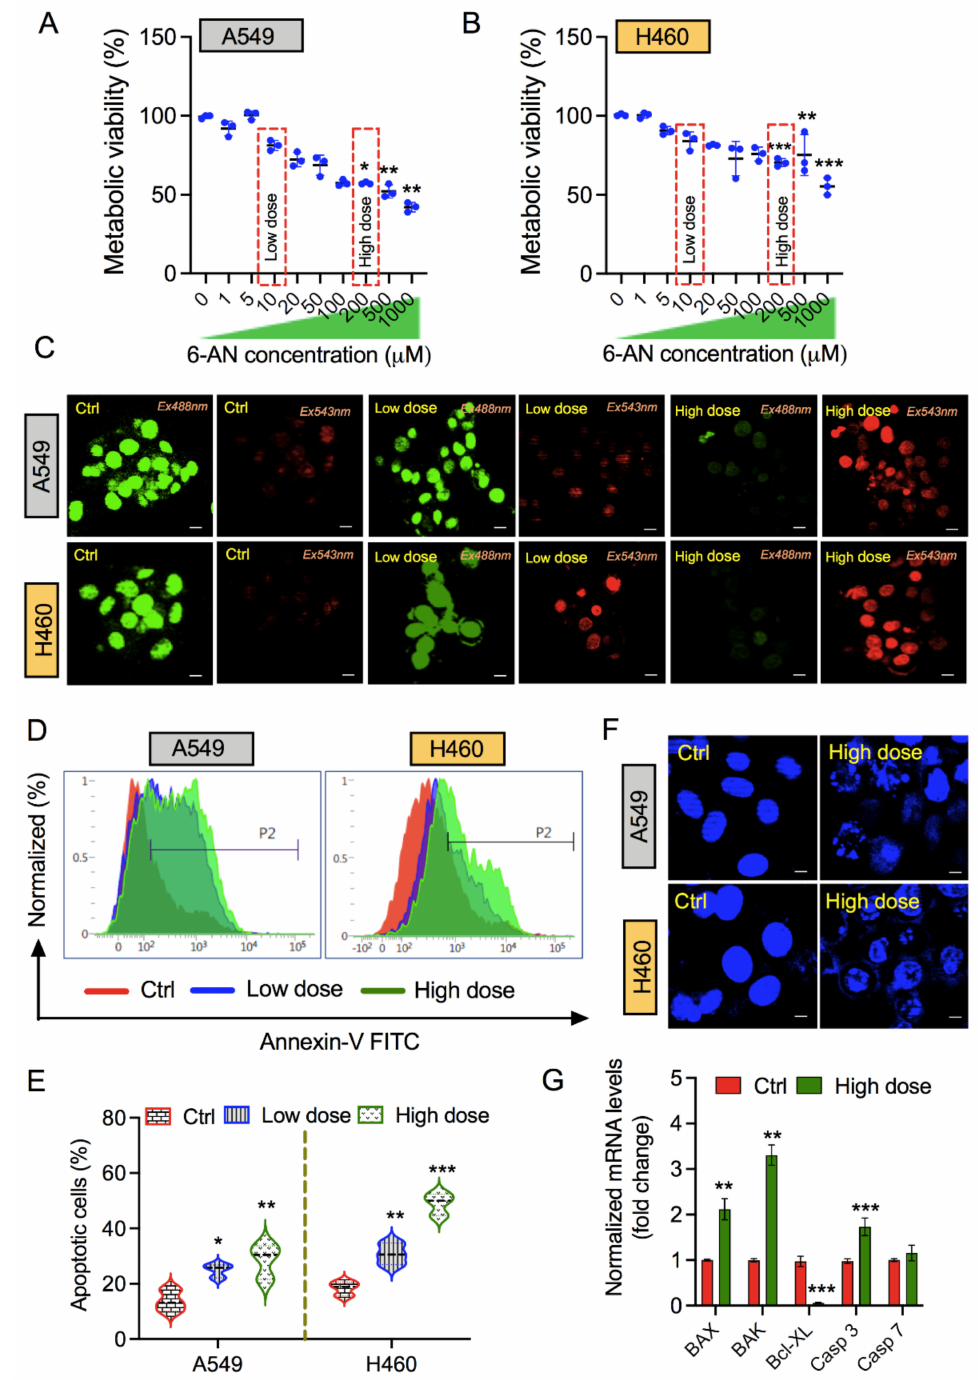
Figure 1. Pentose phosphate pathway (PPP) inhibitor 6-aminonicotinamide (6-AN) promotes apoptotic cell death in non-small lung cancer cells . ( A , B ) Metabolic activity of A549 and H460 lung cancer cells, respectively, when treated at 1000, 500, 200, 100, 50, 20, 10, 5, or 1 µ M concentrations of 6-AN. ( C ) Live/dead cell viability assay of A549 and H460 cells treated for 48 h post 6-AN treat- ment. ( D ) Annexin V-FITC flow cytometric analysis of apoptosis in A549 and H460 lung cancer cells, treated at low (10 µ M) and high (200 µ M) doses of 6-AN treatment. ( E ) Representative graph of total apoptotic percent population of both cell lines observed at indicated doses. ( F ) Immunofluorescence nuclear 4,6-diamidino-2-phenylindole (DAPI) stained images of A549 and H460 cells treated at high doses of 6-AN. ( G ) qPCR analysis of apoptosis related markers in H460 cells in presence or absence of 6-AN treatment. * p < 0.05; ** p < 0.01; *** p <